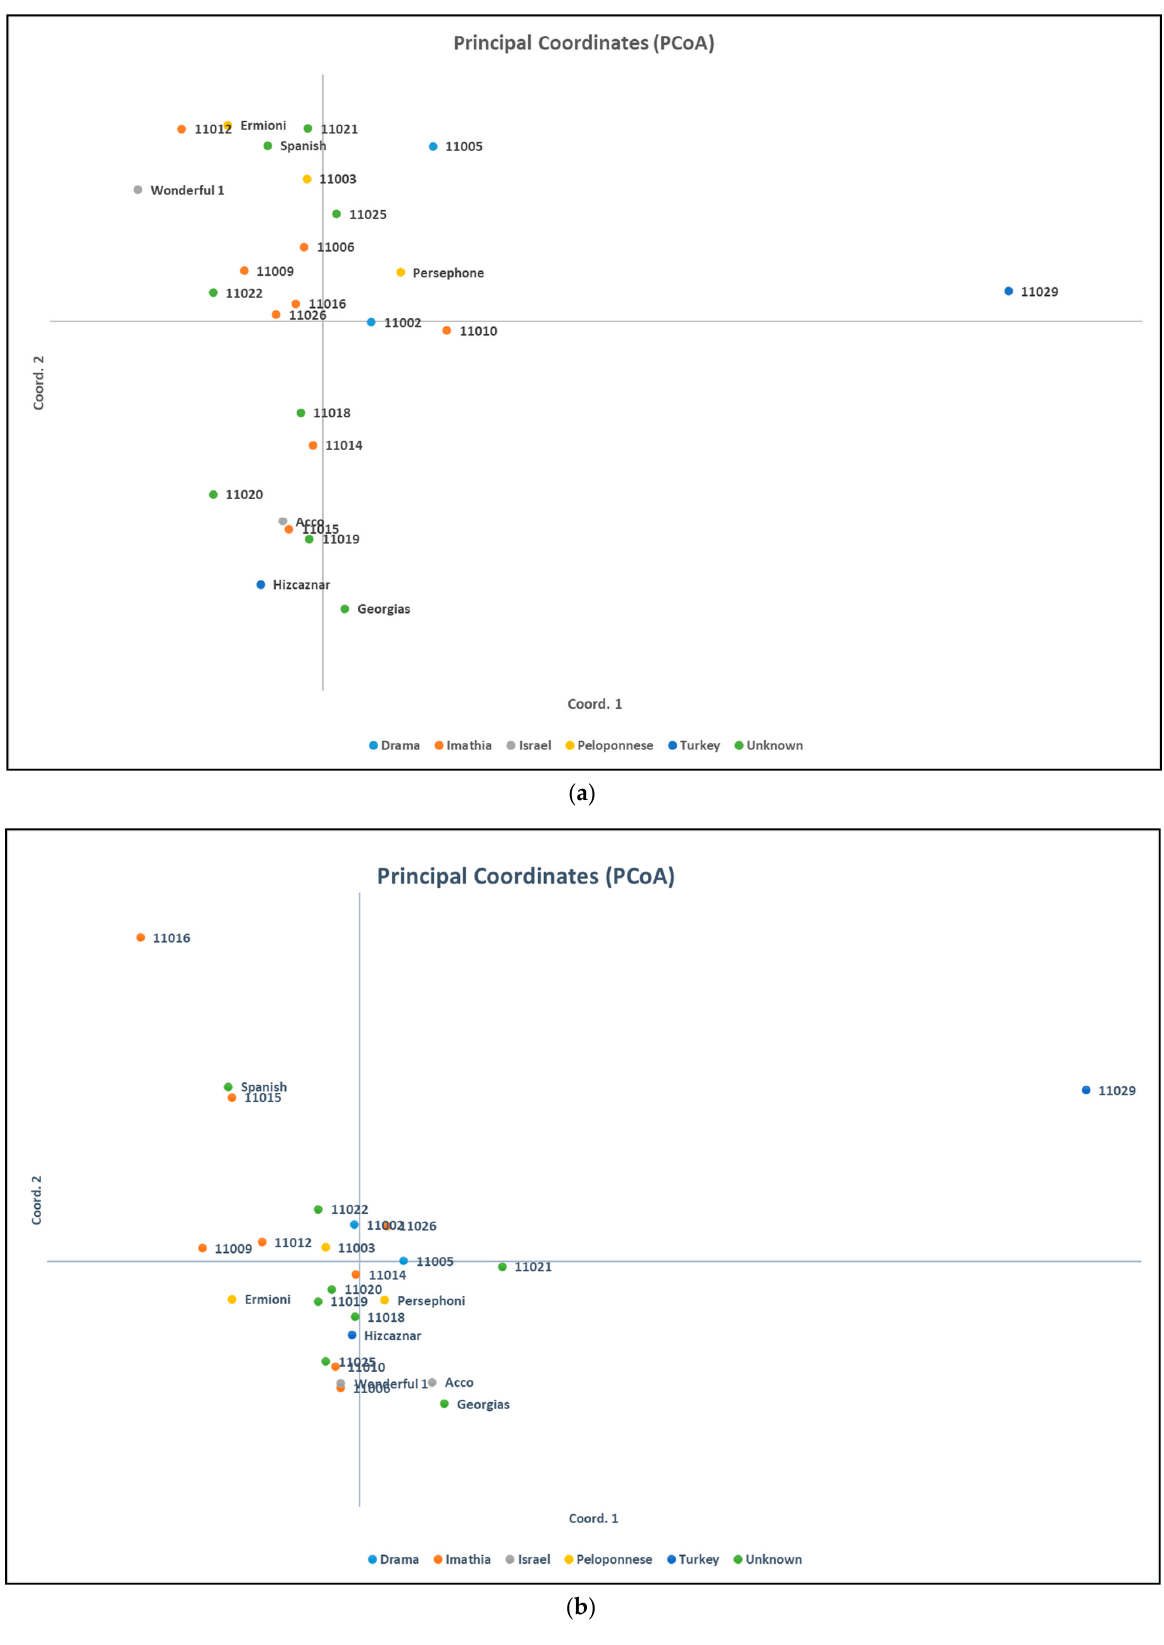
Figure 3. Principal Coordinates Analysis for ( a ) ISSR molecular markers and for ( b ) SCoT molecular markers. The dendrogram obtained from the ISSR markers by UPGMA method grouped the pomegranate cultivars into three wider clusters (Figure 4), while the UPGMA dendro- gram resulted from the SCoT markers grouped the cultivars into eight smaller clusters (Figure 5). Similarities and dissimilarities between the two dendrograms can be easily de- tected. Hicaznar, Georgias, 11019 and 11018 belong to the same cluster in both dendro- grams. Cvs Ermioni, 11009, 11026 and 11022 may belong to the same cluster according to the ISSR dendrogram but according to the SCoT markers two different clusters are formed that are very close to each other. The dendrogram obtained from the combined distance matrix of ISSR and SCoT markers, grouped the pomegranate genotypes into three clusters (Figure 6). Cultivars 11012, Wonderful 1, 11009, Ermioni, 11026, 11022, 11003, and Spanish form the first cluster. The second cluster contained 11021, 11005, Persephone, 11002, 11010, 11006, 11025, while the third cluster contained Georgias, 11019, 11018, 11015, 11014, Hica- znar, Acco, and 11020. Accessions 11016 and 11029 were not included in any cluster.